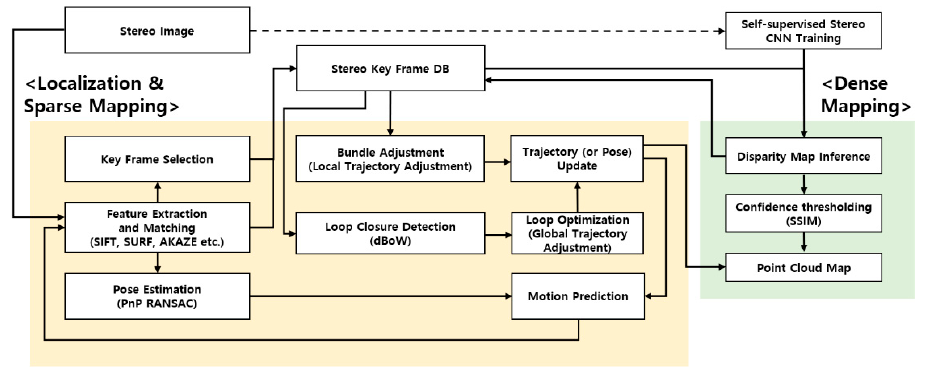
Figure 2. Overview of a robotic mapping system.